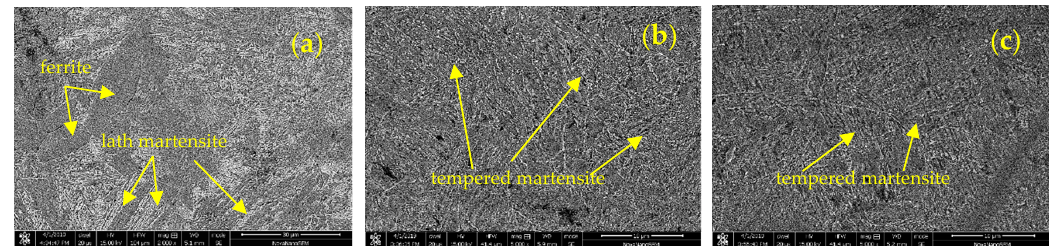
Figure 8. Scanning electron microscopy (SEM) images for ( a ) BM, ( b ) HD, and ( c ) CF materials.